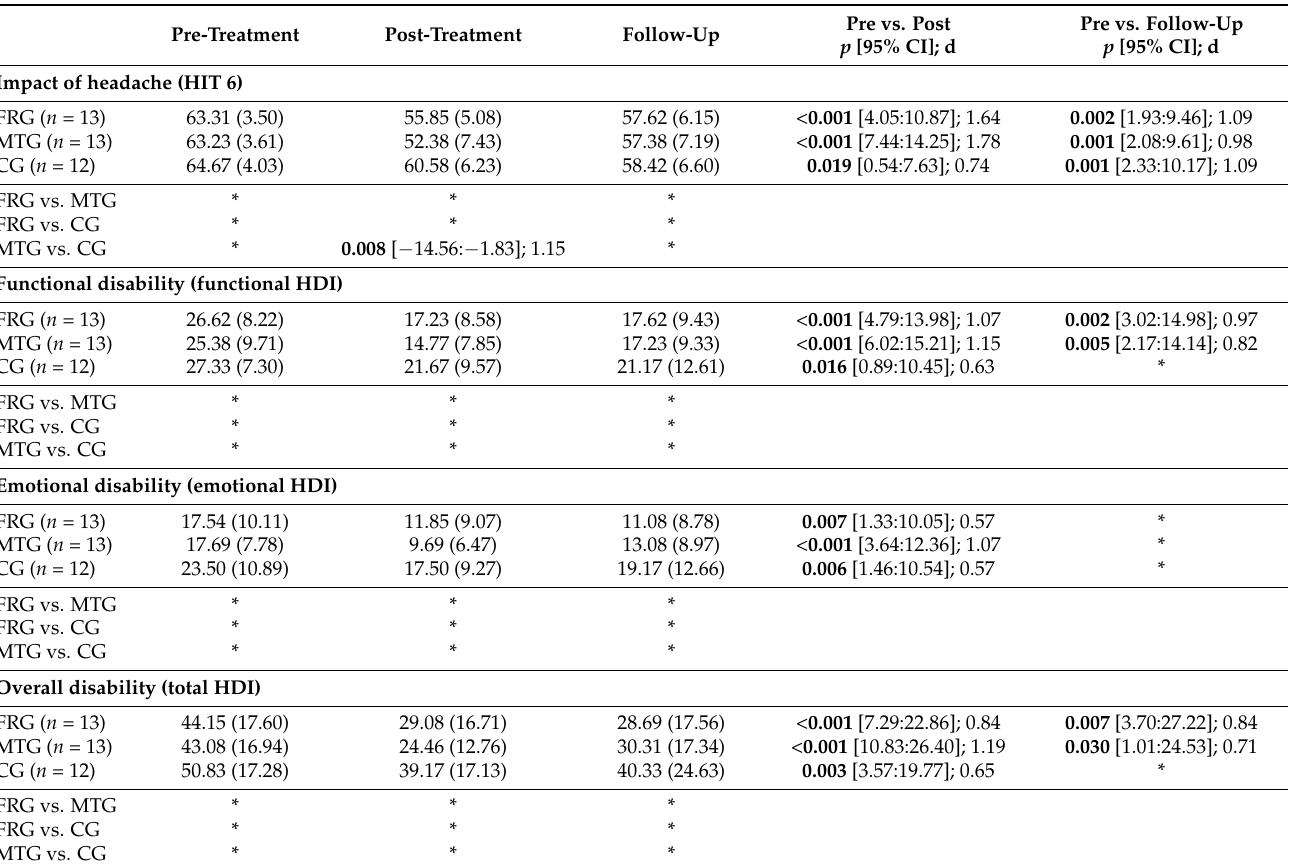
Table 5. Results of the multiple comparisons for HIT 6 and